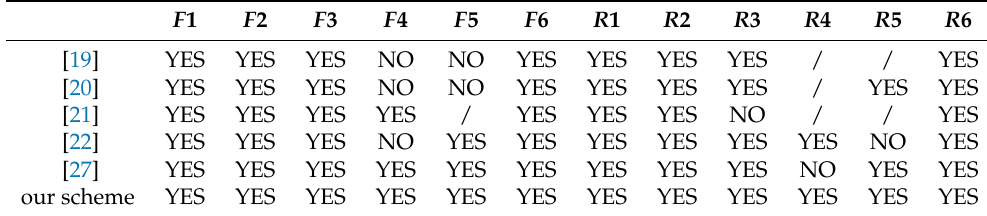
Table 3. Security and functionality comparison